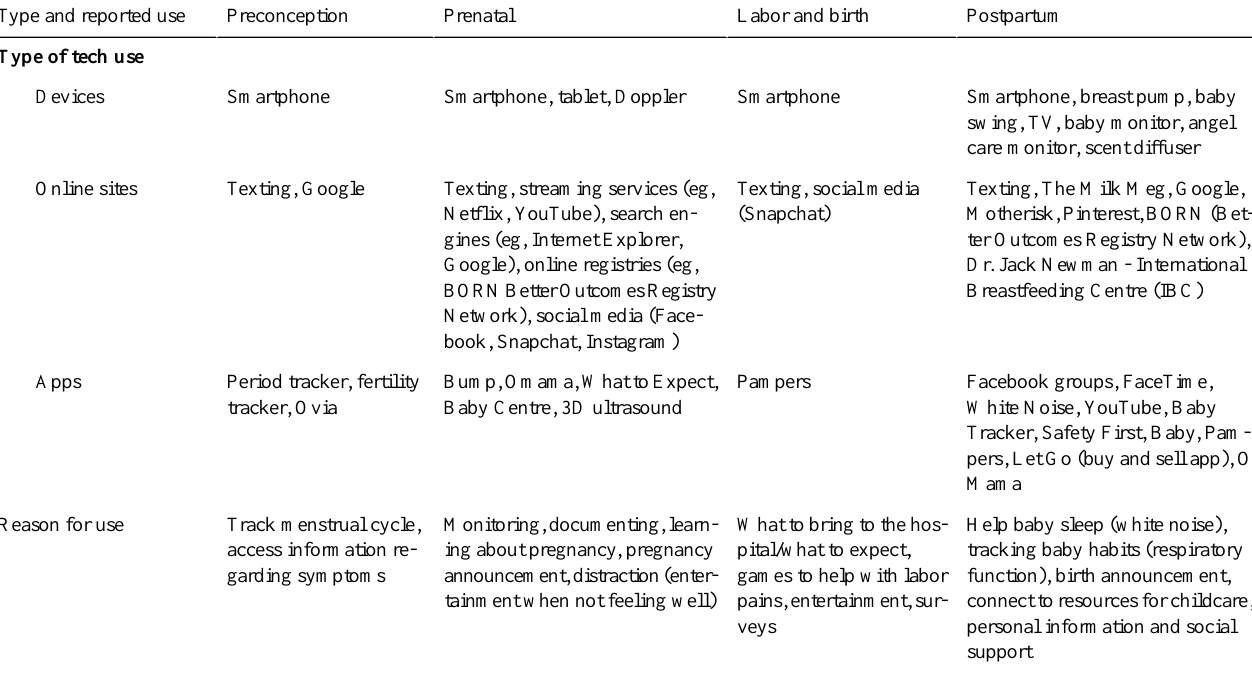
PostpartumLabor and birthPrenatalPreconceptionType and reported use